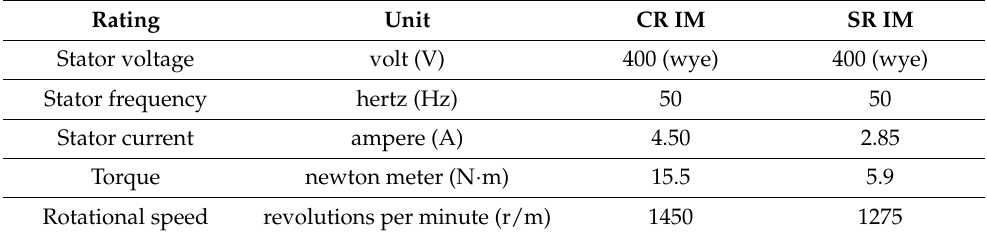
Table A1. The rated parameters of the tested CR and SR IMs.